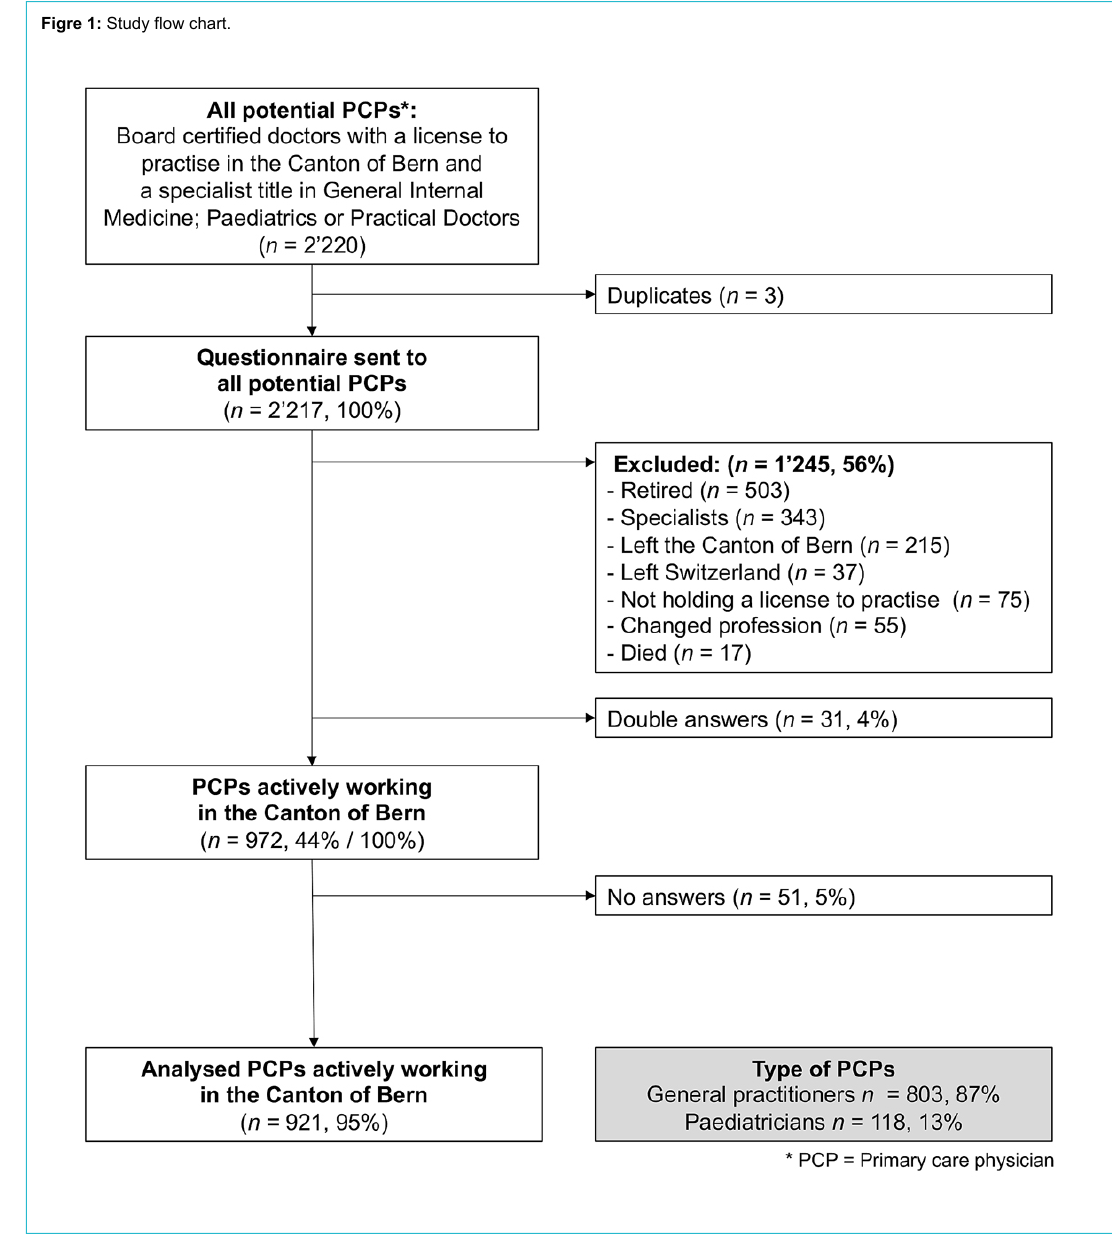
Figre 1: Study flow